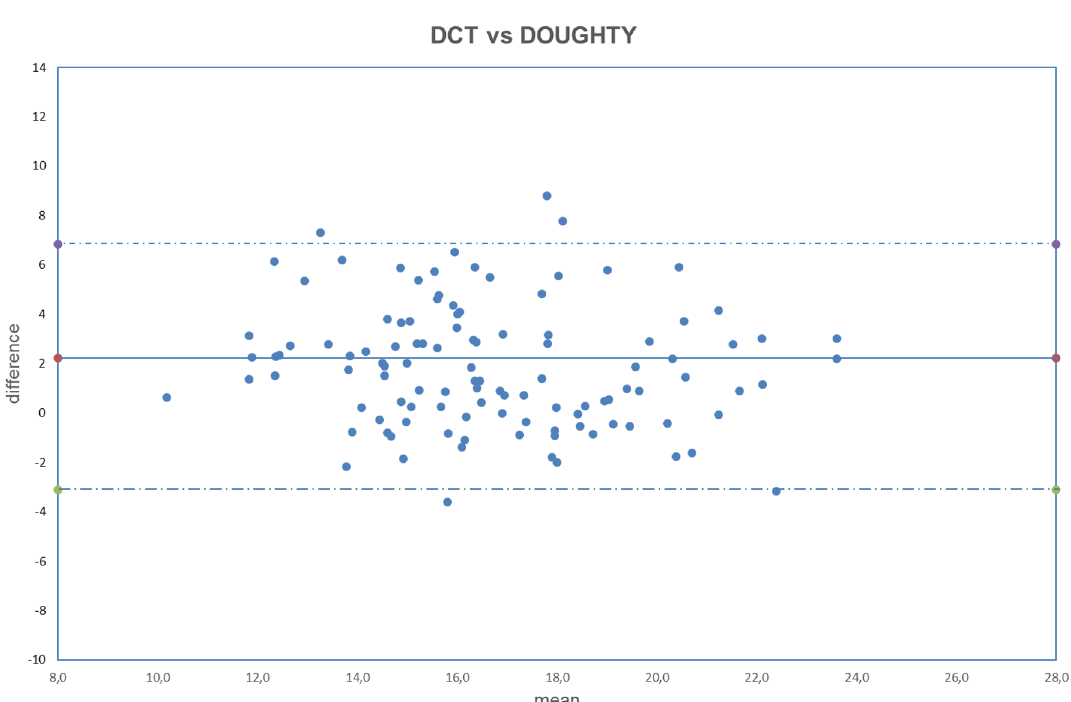
Figure 6. Bland–Altman plot between IOP measured with DCT and GAT corrected with Doughty formula. Dashed line: mean difference. Dash-dotted lines: mean difference (2.22 mmHg) ± 2 standard deviation (2.52 mmHg) of the